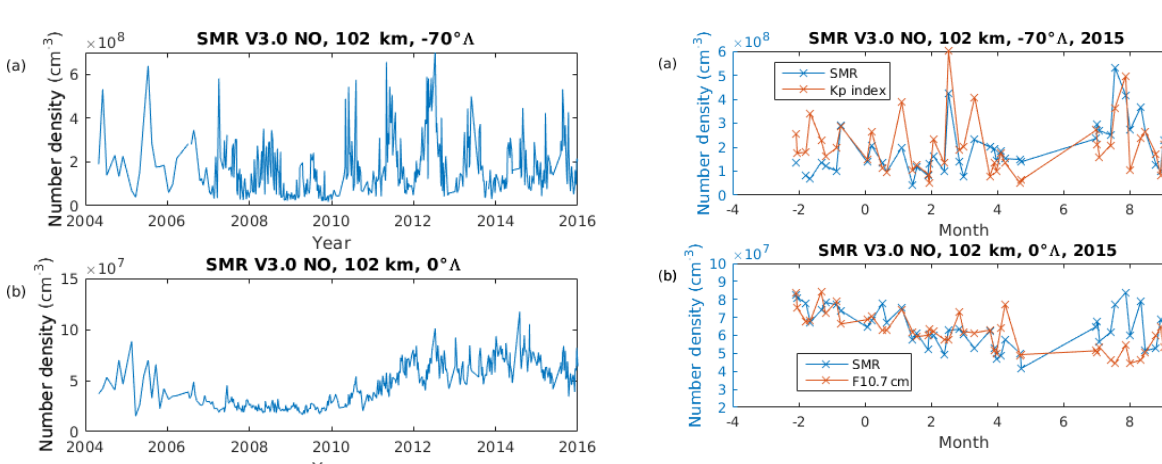
Figure 5. (a) Daily mean NO derived from Odin SMR at 102km and − 70 ◦ magnetic latitude with the Kp index (b) 102km and 0 ◦ (cid:51) with the F10.7cm flux.